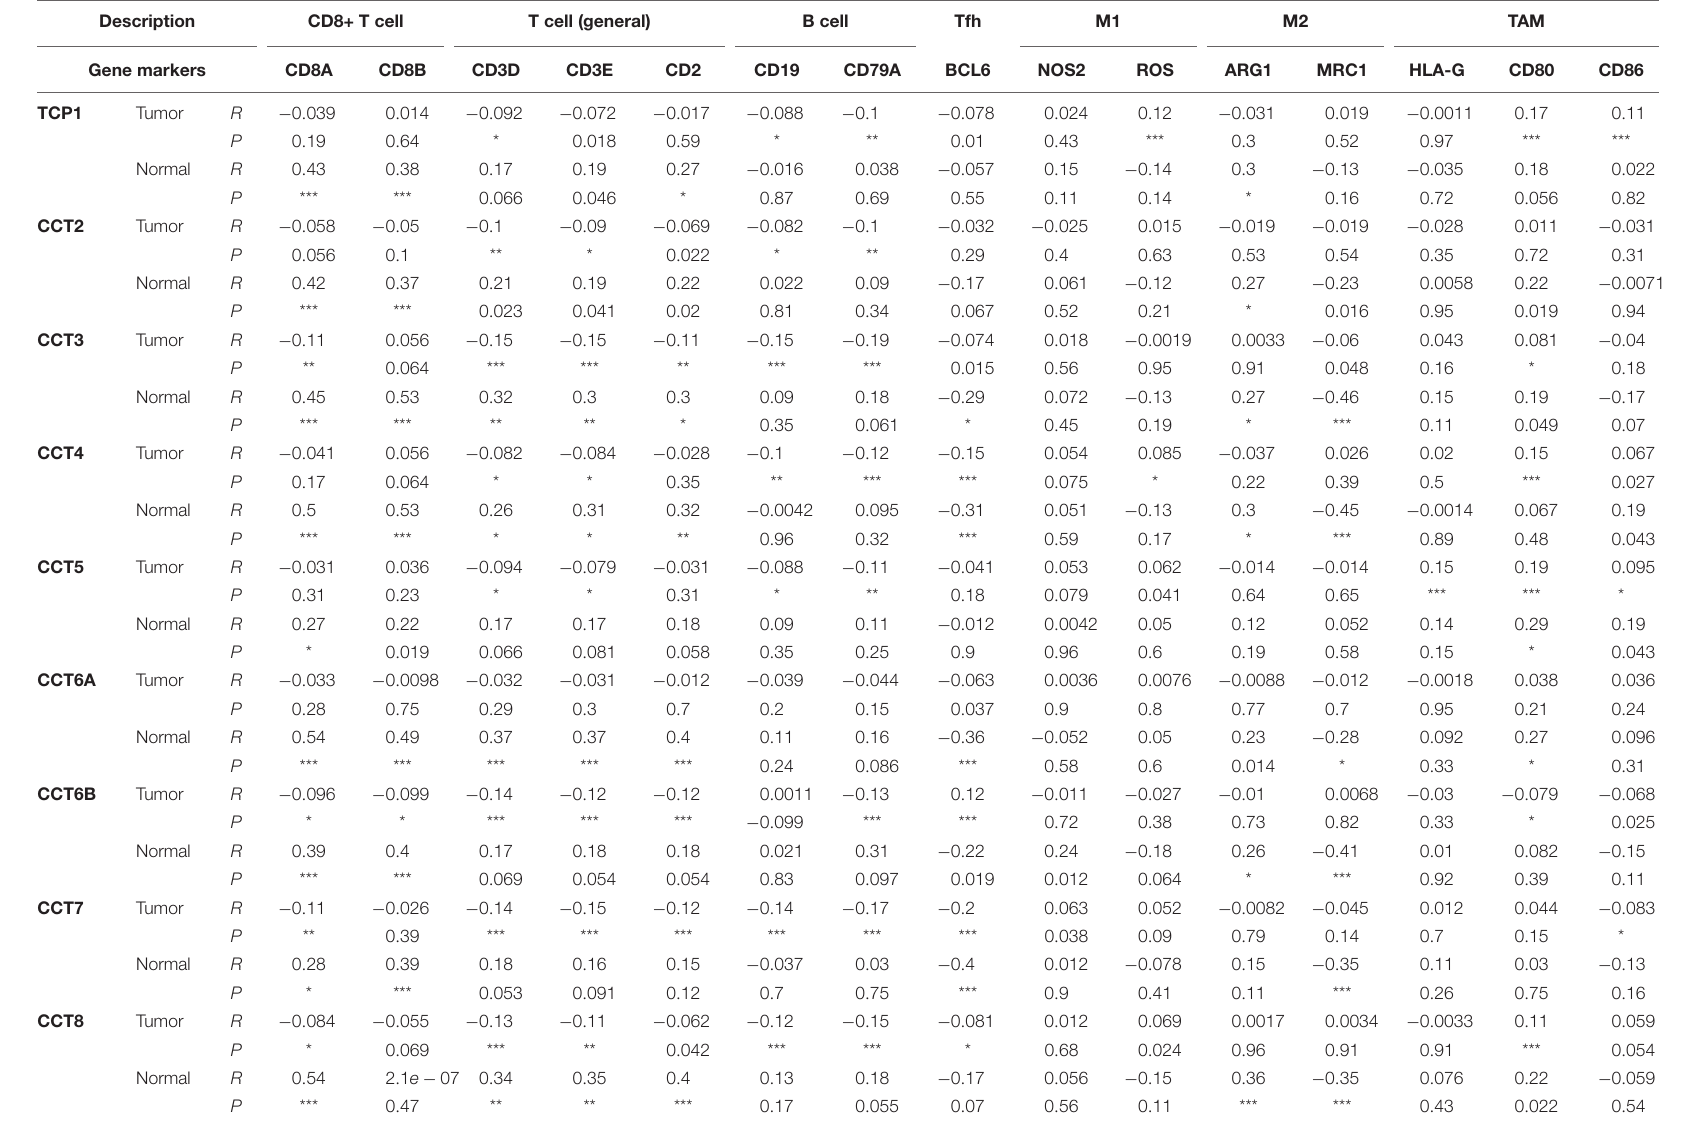
TABLE 1 | Correlation analysis between TRiC and genes markers of immune cells in GEPIA. Description CD8+ T cell T cell (general) Gene markers